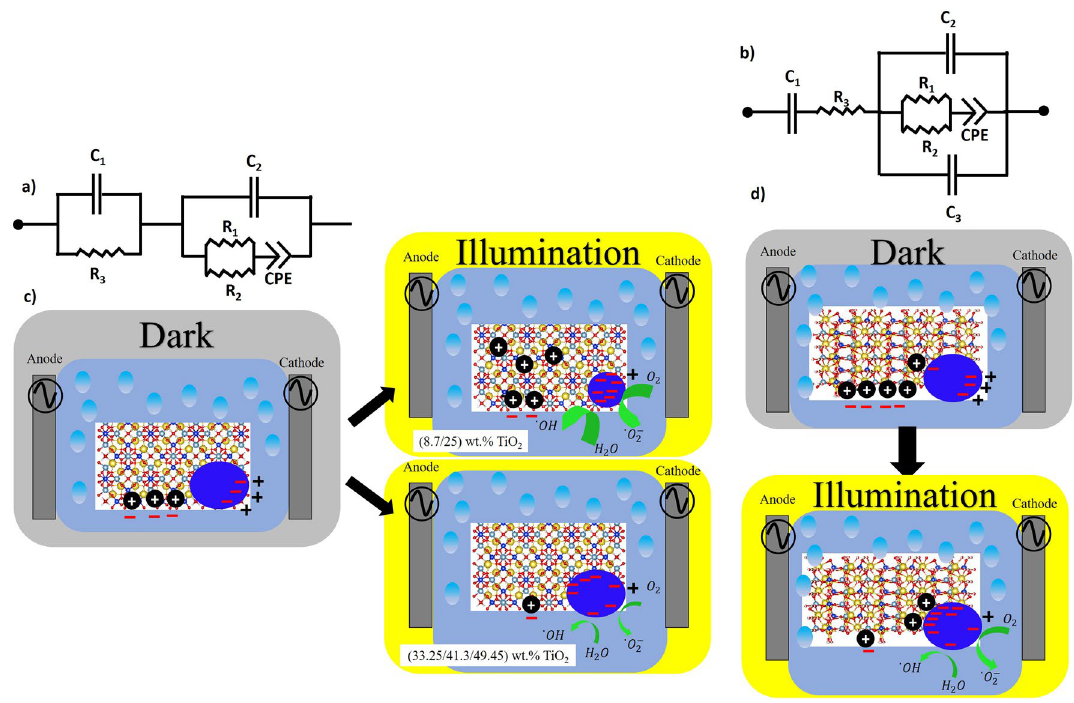
Figure 10. Equivalent circuit for ( a ) HYD-T and ( b ) CAN-T hybrid materials; schematic processes in the ( c ) HYD-T and ( d ) CAN-T hybrid materials.